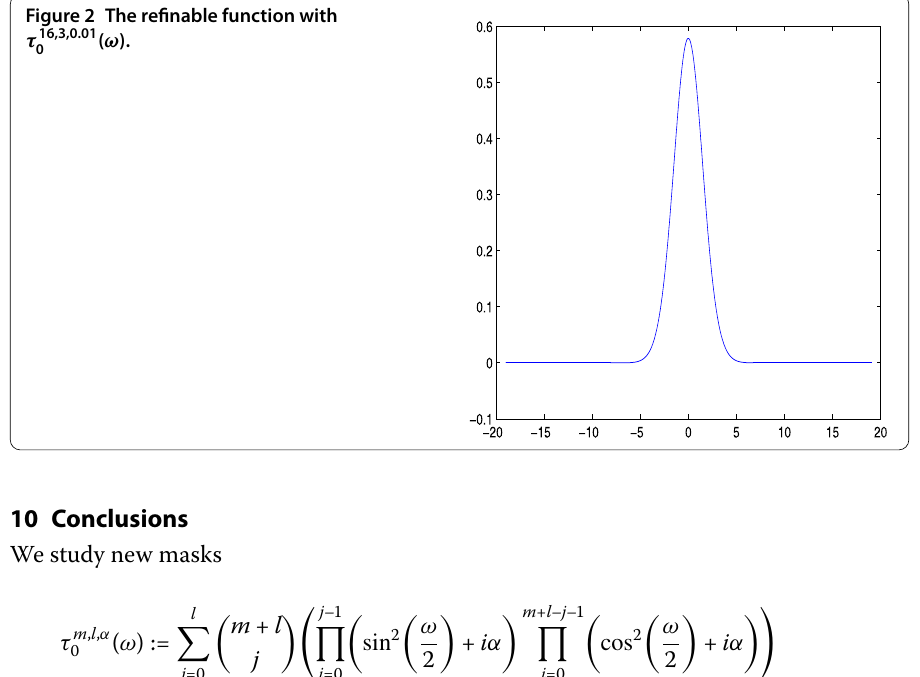
Figure 2 The refinable function with τ 16,3,0.01 ( ω 0